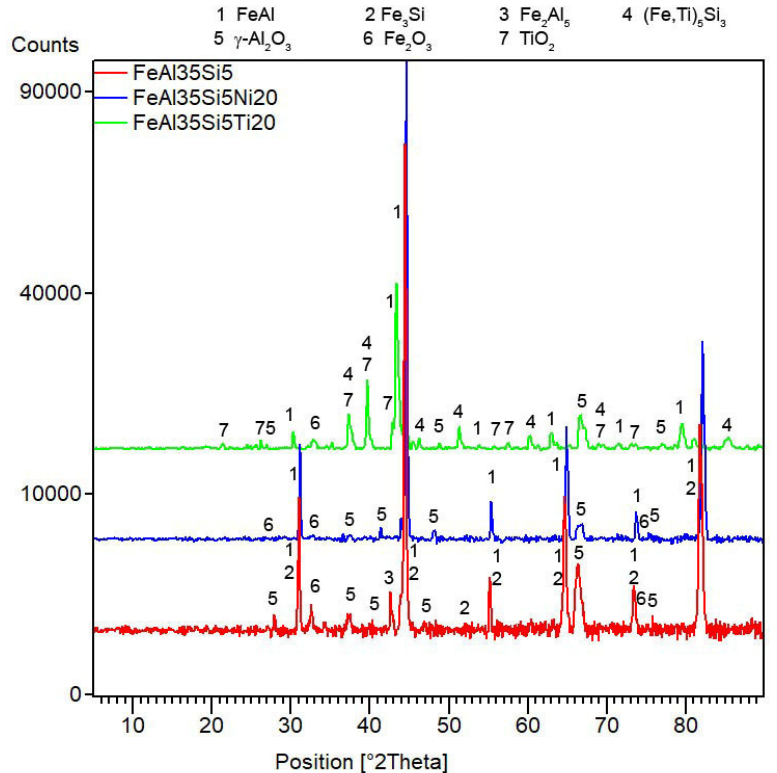
Figure 9. XRD patterns of the tested bulk alloys after cyclic oxidation at 800 ◦ C for 400 h in air.